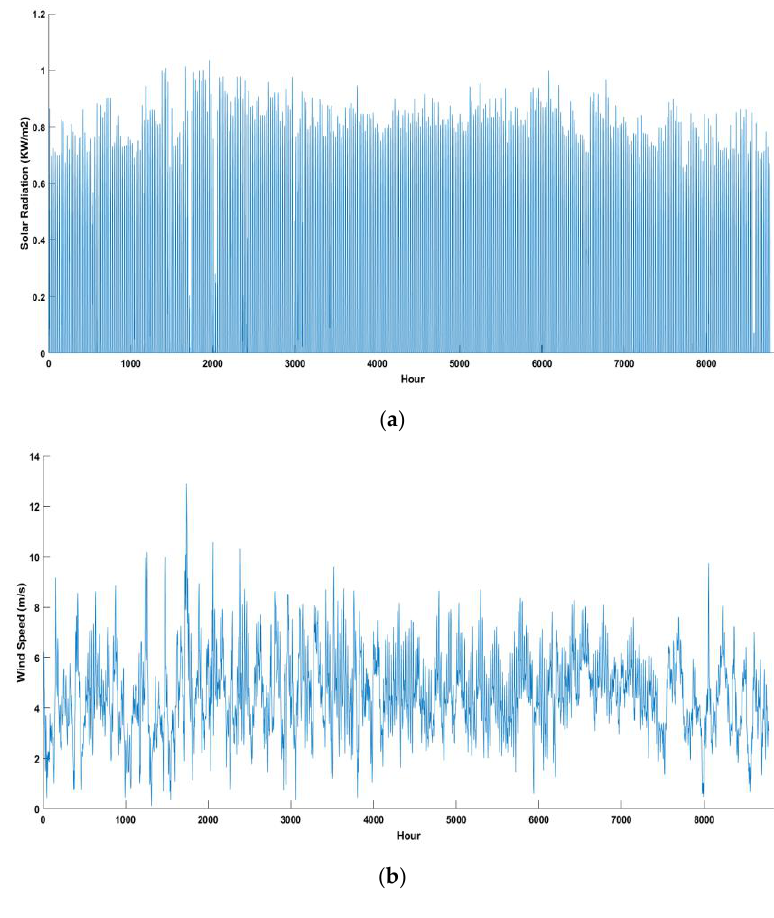
Figure 3. One-year climate conditions data; ( a ) solar radiation, and ( b ) wind speed.